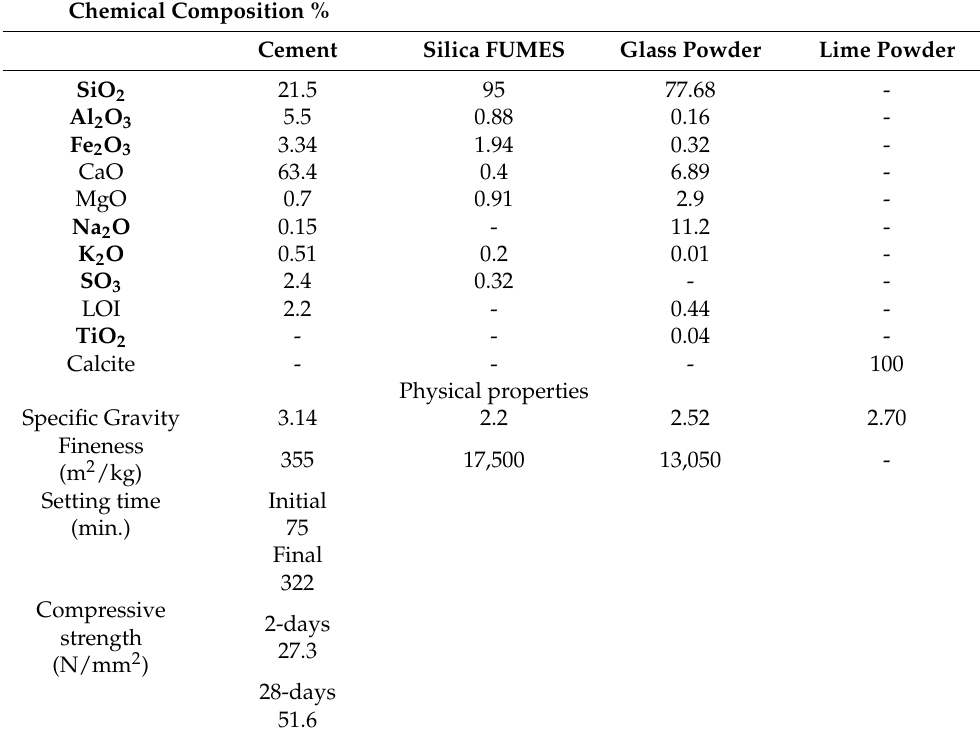
Table 1. Chemical composition and physical properties of used fine